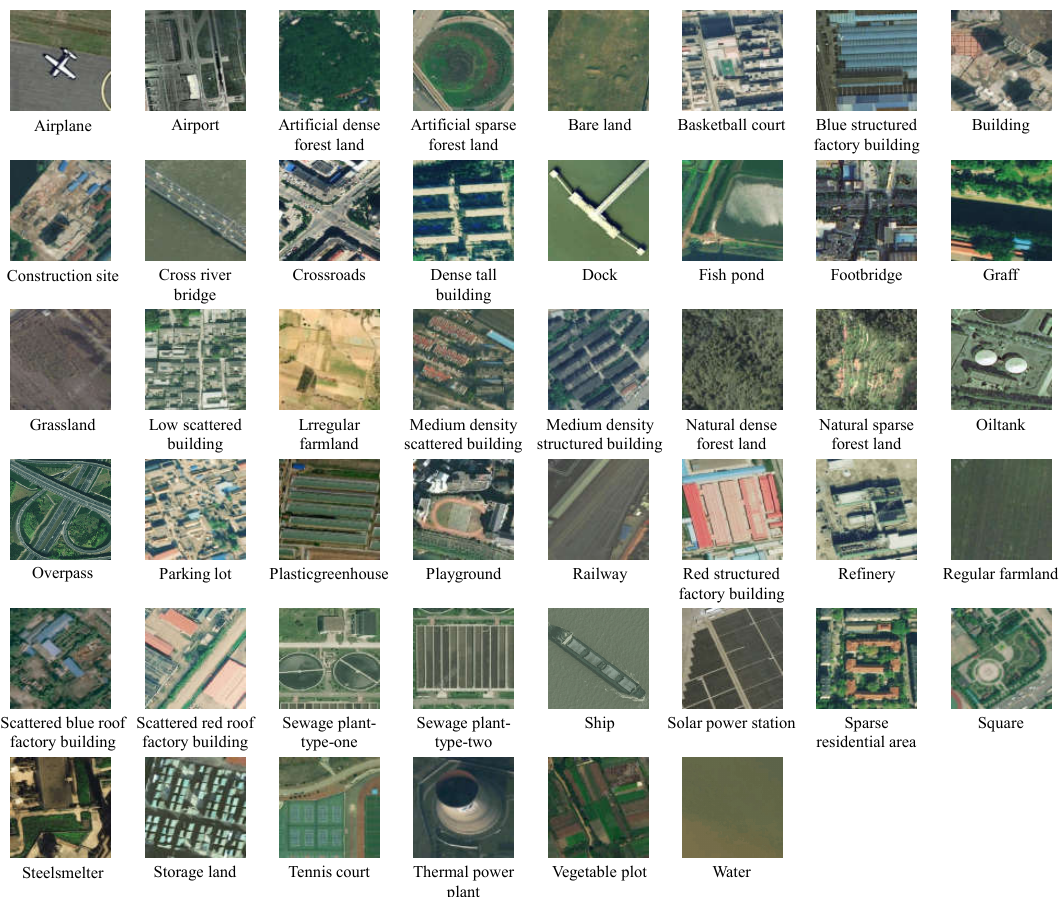
Figure 8. Example images of each category in the RSD46-WHU